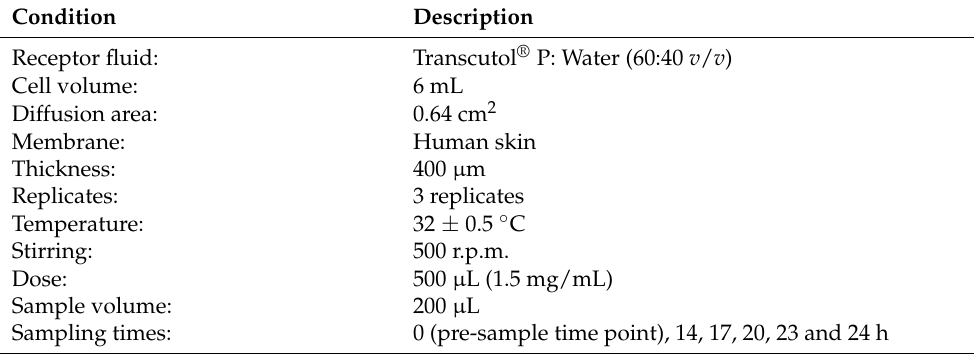
Table 2. Experimental conditions for Ex vivo skin permeation